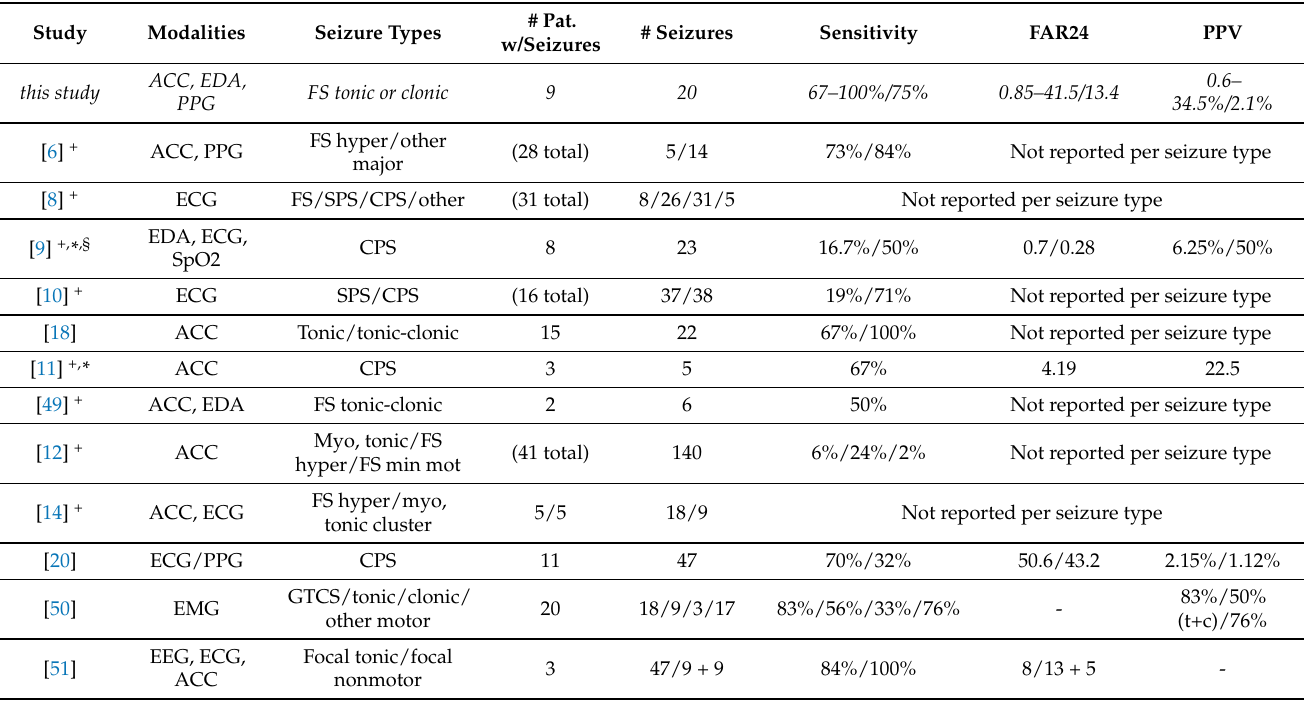
Table 2. Related work compiled from Beniczky et al., 2021 [4], and this study as comparison. Only those works are included that involve seizure types relevant to this study, that is, any of focal motor seizures, SPS, CPS, or other non-generalized seizures. FAR24: false alarm rate per 24 h; PPV: positive predictive value; FS: focal seizures; SPS: simple partial seizures; CPS: complex partial seizures; hyper: hypermotoric seizures; myo: myoclonic seizures; FS min mot: focal seizures with minimal motor